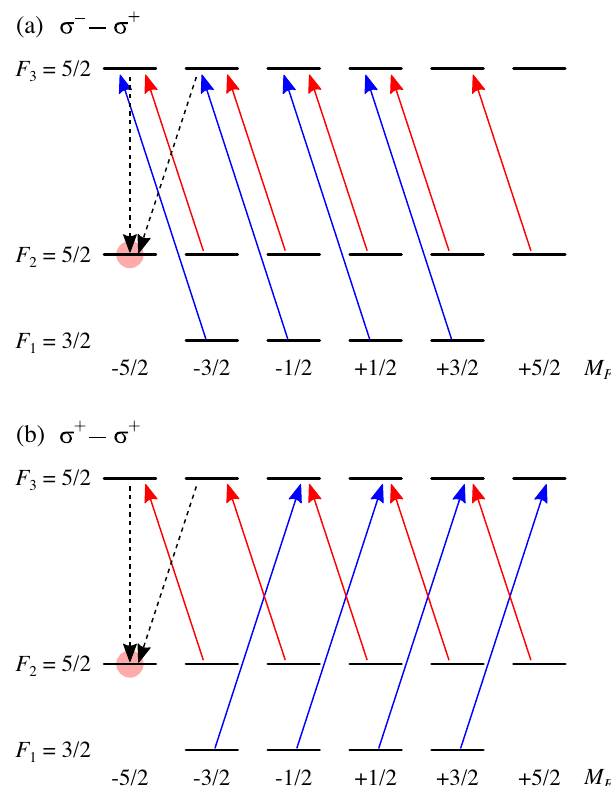
FIG. 4. Level scheme with M F substates for the explanation of the dark state in the Λ -scheme with two circularly polarized laser beams. The upper panel (a) displays the case of σ − ð UV Þ – σ þ ð IR Þ polarization, while the lower panel (b) corre- sponds to the σ þ ð UV Þ – σ þ ð IR Þ